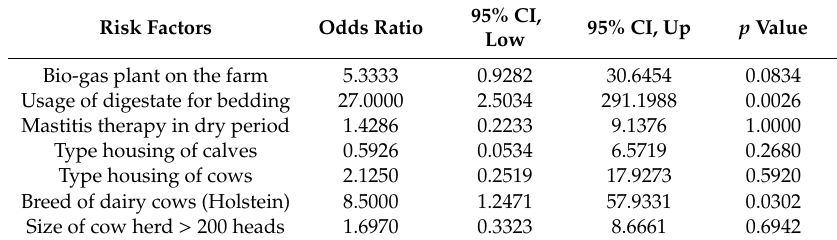
Table 2. Risk factors associated with Clostridioides ( Clostridium ) di ffi cile carriage in calves. CI: confidence